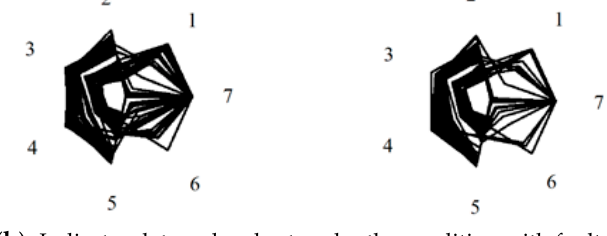
Figure 6. Indicator data radar chart preprocessing.